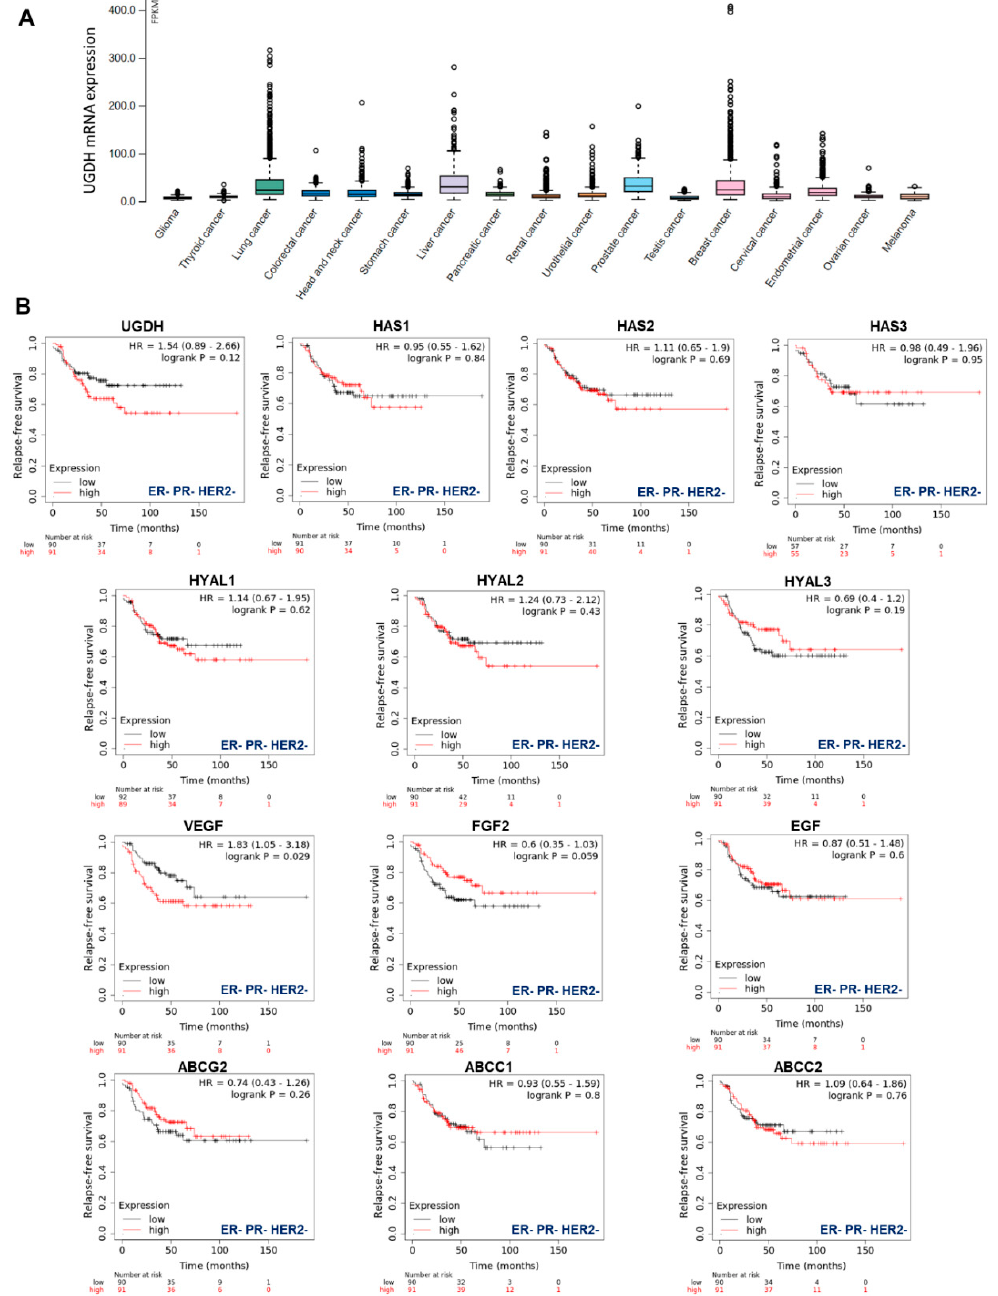
Figure 1. TCGA analysis of UGDH expression in different types of cancers. ( A ) Frequency of UGDH expression in different types of solid tumors. RNA ‐ seq data of 17 cancer types are plotted as median number fragments per kb (FPKM) of exon per million reads generated by The Cancer Genome Atlas (TCGA). Points are displayed as outliers if they are above or below 1.5 times the interquartile range. The cancer types are color-coded according to which type of normal organ each cancer originated from. ( B ) The prognostic values of the expression of main genes involved in HA metabolism (UGDH, HA synthases and hyaluronidases), angiogenesis (VEGF, FGF2, EGF) and drug resistance (ABC drug transporters) in patients with breast cancer stratified by hormone receptor status Kaplan–Meier relapse ‐ free survival curves are plotted based on triple ‐ negative expression of ER, PR and Her2 treated with chemotherapy ( n = 181). Log-rank p values and hazard ratios (HRs; 95% confidence interval in parentheses) are shown. The corresponding Affymetrix IDs are: 203342_at_UGDH; 207316_at_HAS1; 206432_at_HAS2; 223541_at_HAS3; 210619_at_HYAL1; 206855_at_HYAL2; 211728_at_HYAL3; 210512_at_VEGF; 204422_at_FGF2; 206254_at_EGF; 209735_at_ABCG2; 202804_at_ABCC1 and 205887_at_ABCC2.